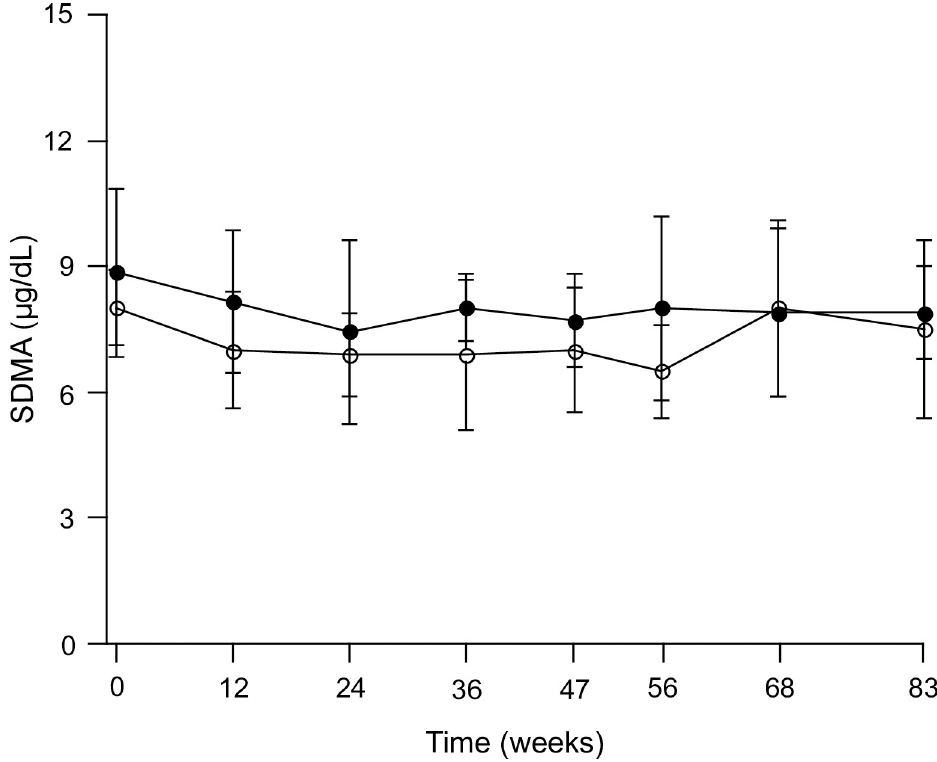
Fig 1. Serum SDMA concentration of the dogs in the control group (closed circles, n = 8) a and weight-change group (open circles, n = 8) throughout the study. The weight-change group underwent three consecutive phases, namely the weight gain phase (week 0–47), weight-stable phase (week 47–56) and weight-loss phase (week 56–83). The subjects from the control group were kept at an ideal body weight. a Data from 1 dog missing. SDMA, symmetric